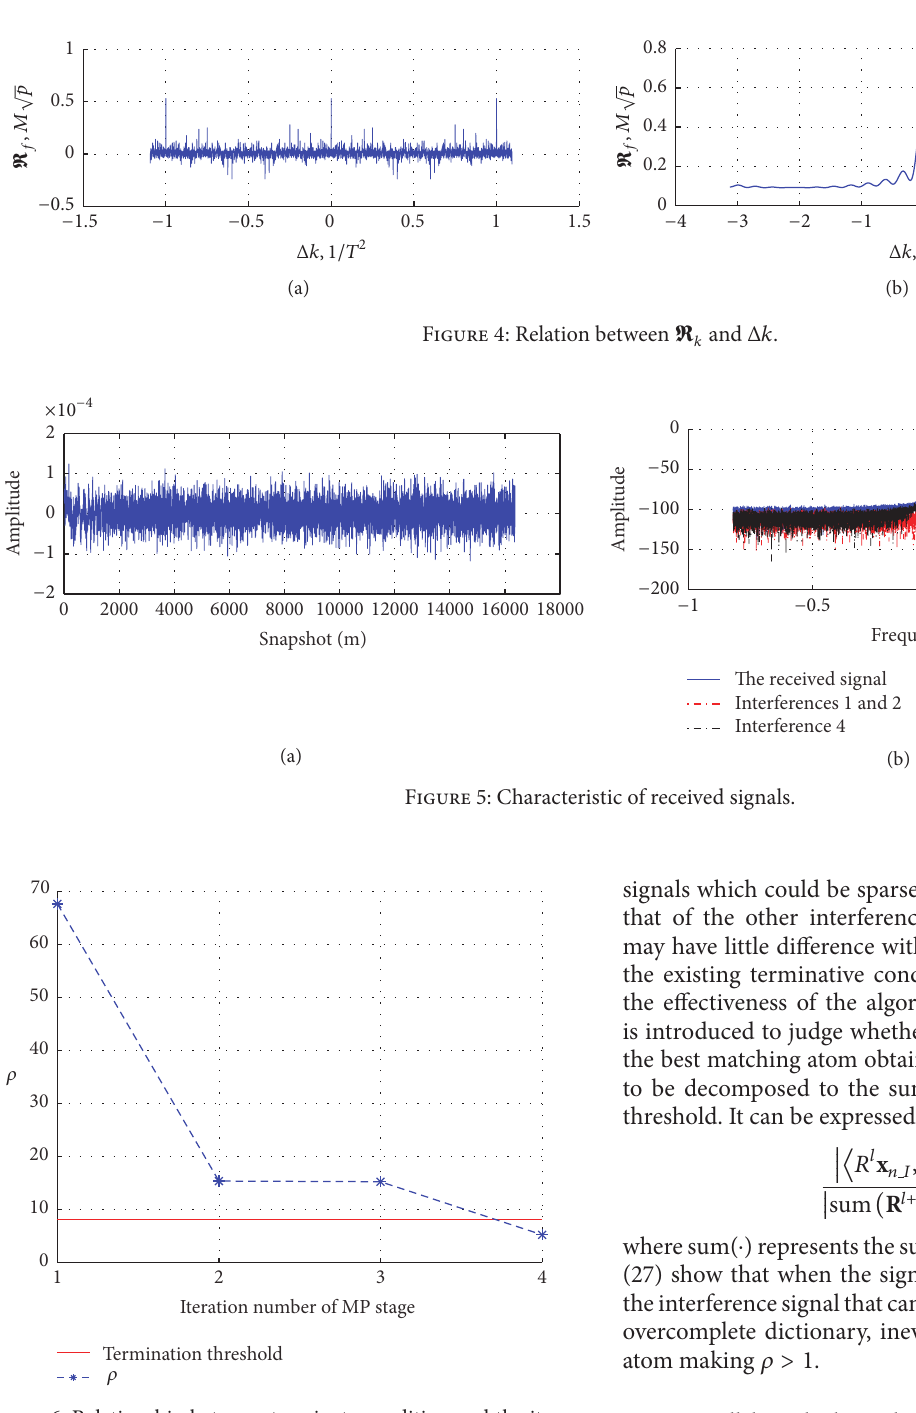
Figure 6: Relationship between terminate condition and the itera- tion